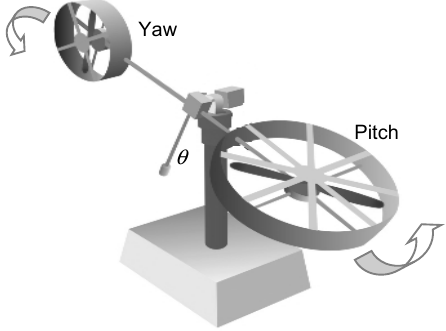
Figure 19. Experimental twin-rotor multi-input multi-output system (TRMS) setup [39].